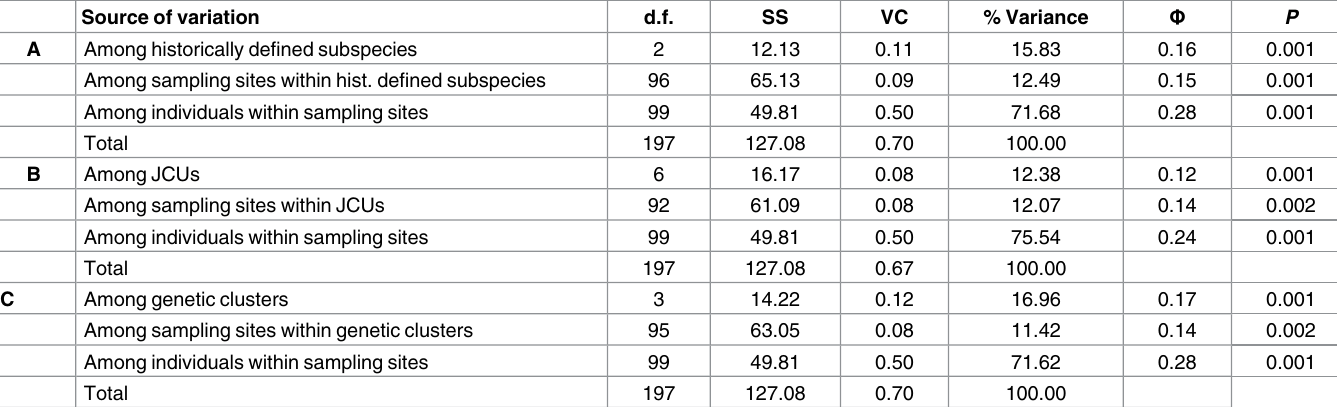
Table 5. Hierarchical analysis of molecular variance (AMOVA) in Mesoamerican